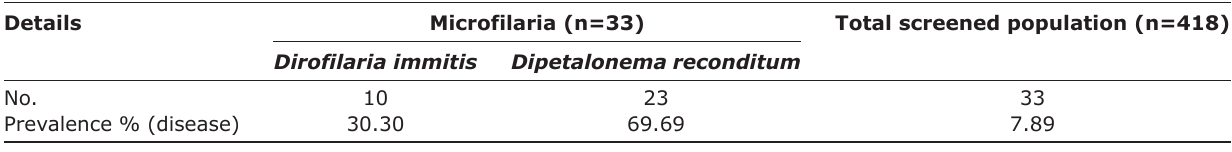
Table-1: Overall prevalence and distribution of microfilariae ( D. immitis and D. reconditum ) in dogs from Gujarat state, India.